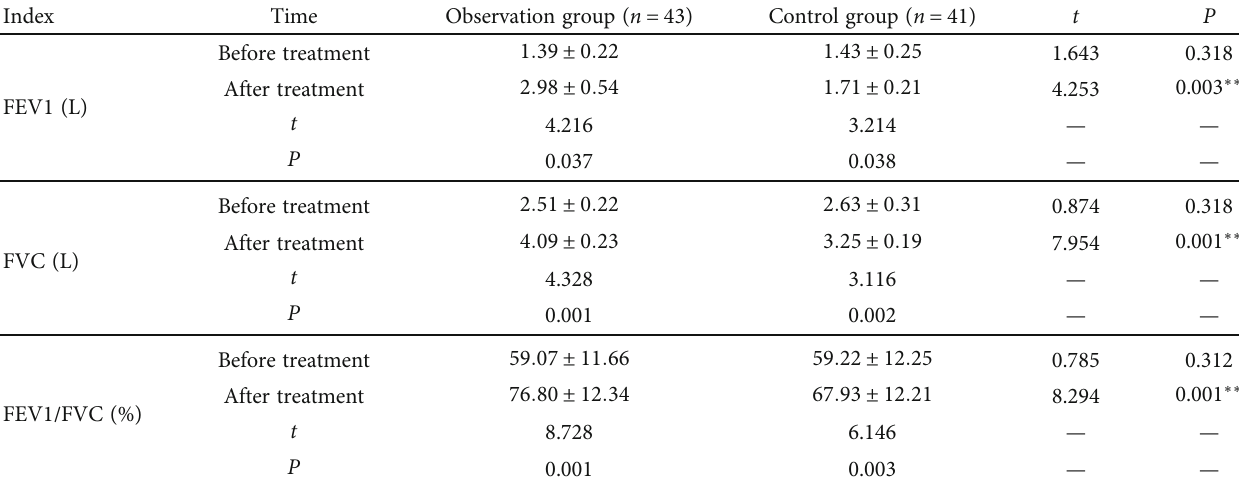
Table 2: Comparison of lung function indexes between the two groups after